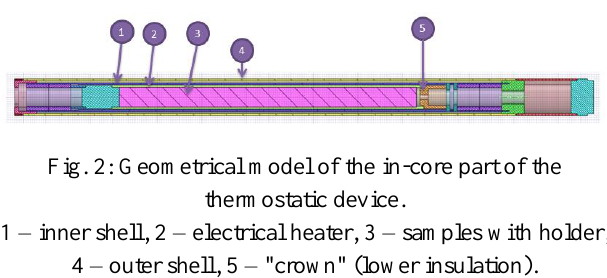
Fig. 1: Irradiation positions in MARIA reactor core